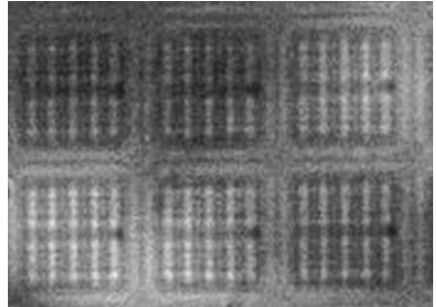
Figure 7: SAM images of TF-cells after the thermal shock